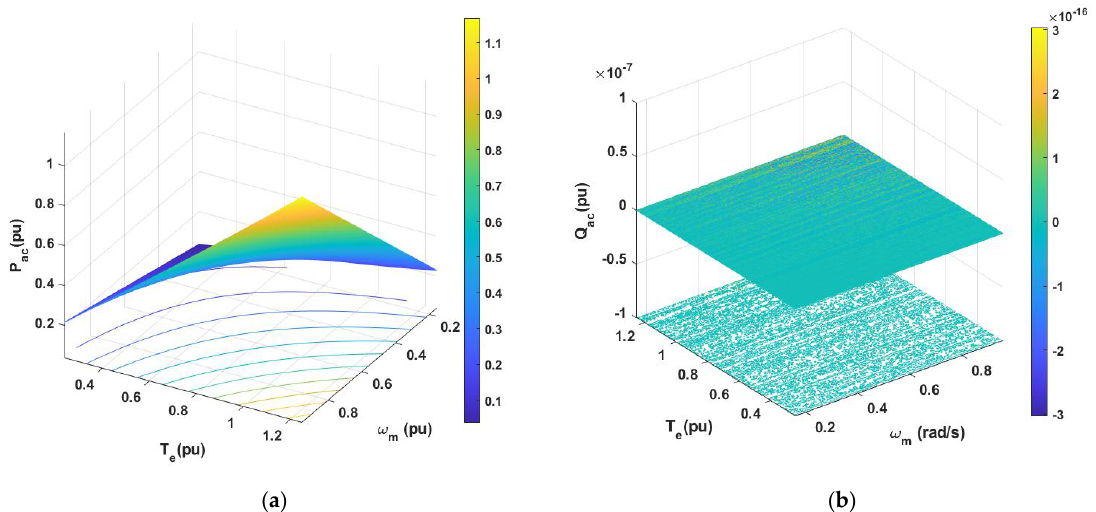
Figure 5. Energy characteristics: ( a ) active power P ac and ( b ) reactive power Q ac with optimization. Analytical results of PMSM control with energy optimization shown in Figure 5